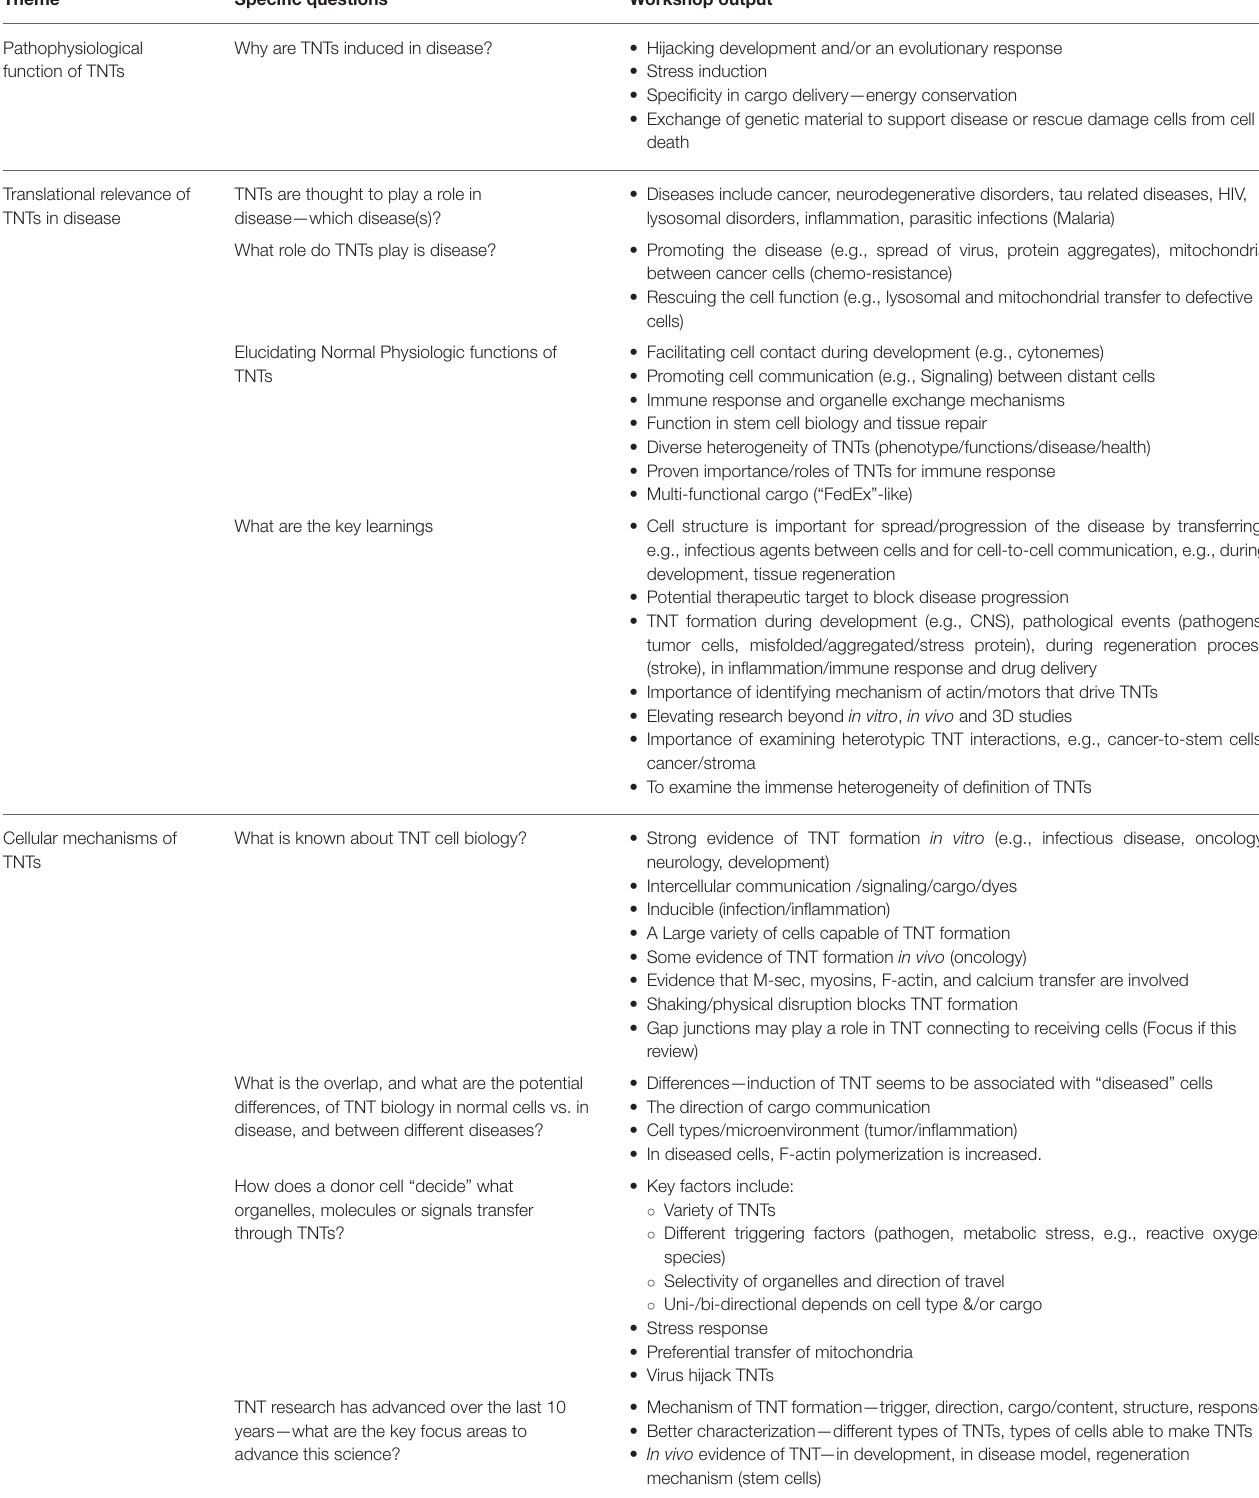
TABLE 1 | Open questions in the area of TNT and gap junctions.